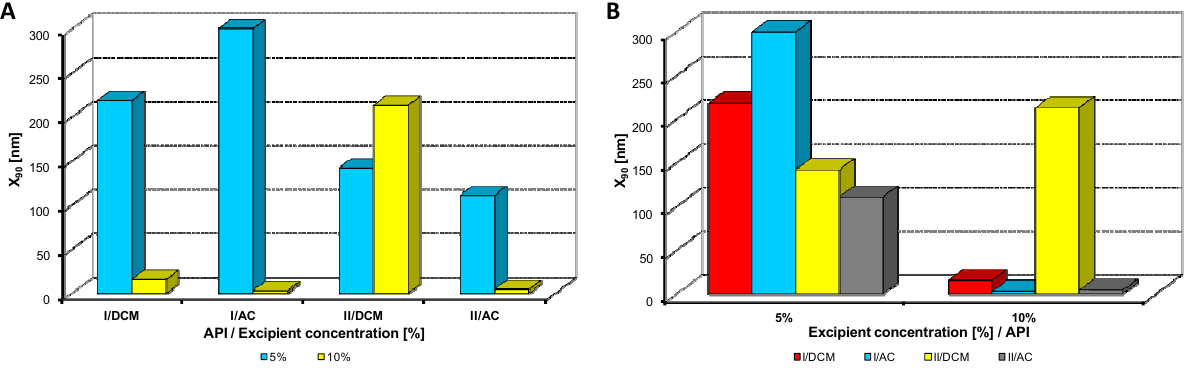
Figure 2. Dependence of particle size (x [nm]) of model APIs I , II on concentration [%] 90 of Tween 80 in dichloromethane (DCM) or acetone (AC). ( A ) Samples are grouped according to APIs; ( B ) samples are grouped according to excipient percentage. For clarity sake, the values on y-axis are only to 300 nm.